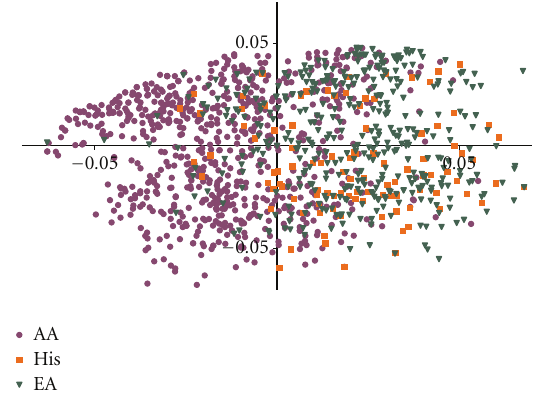
Figure 1: Principal component (PC) analysis including all cases and controls. A. shows the first PC ( x -axis) versus the second PC ( y -axis) for each subject. Each dot represents one subject and is color-coded by self-reported ancestral background (AA:African- American, His: Hispanic American,